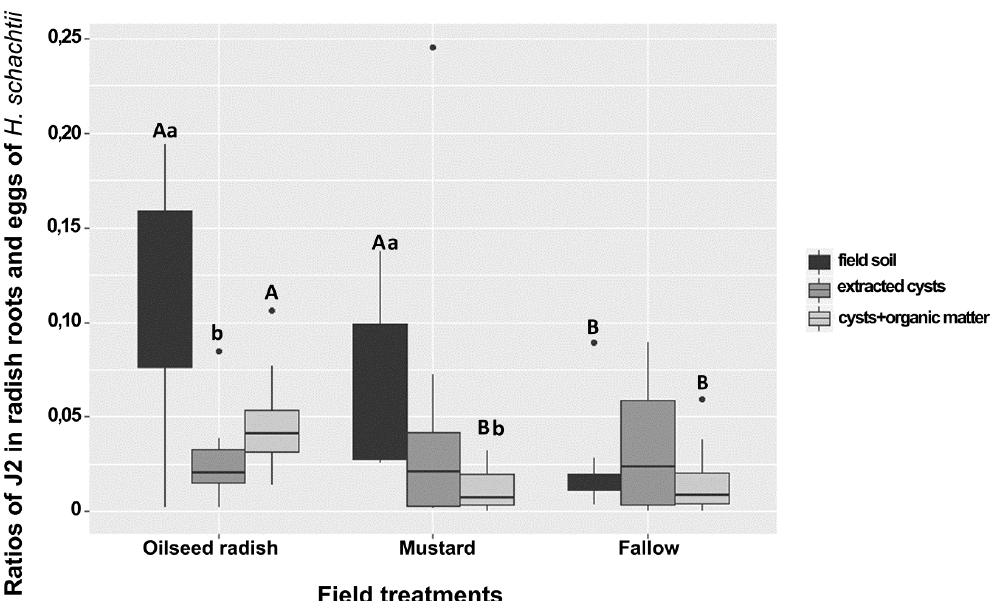
Figure 2. Ratios of J2 in radish bioassay roots and eggs of Heterodera schachtii from sampling at Gross Munzel in plots of oilseed radish, yellow mustard, and fallow treatment. (a,b) compare the median numbers within each group. (A,B) compare the median numbers between groups (Wilcoxon rank test, p < 0.05, n = 24). The asterisk punctuations above the box plot charts refer to the outlier data that markedly deviated from the dataset occurring in each bioassay. The comparison between treatments was carried out at the same type of bioassay.